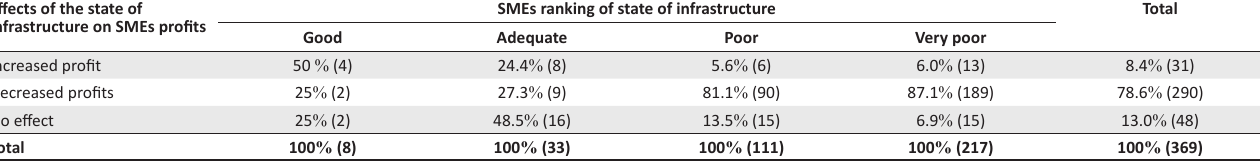
TABLE 3: Showing the cross-tabulation of SMEs ranking of the state of infrastructure and the profits of sampled SMEs. Effects of the state of infrastructure on SMEs profits